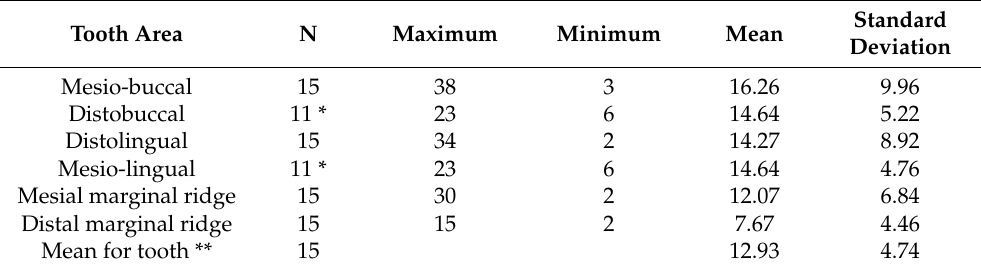
Table 1. Occlusal vertical discrepancies ( µ m) of crowns in the self-adhesive resin cement (SARC) group measured at 6 points in each tooth.